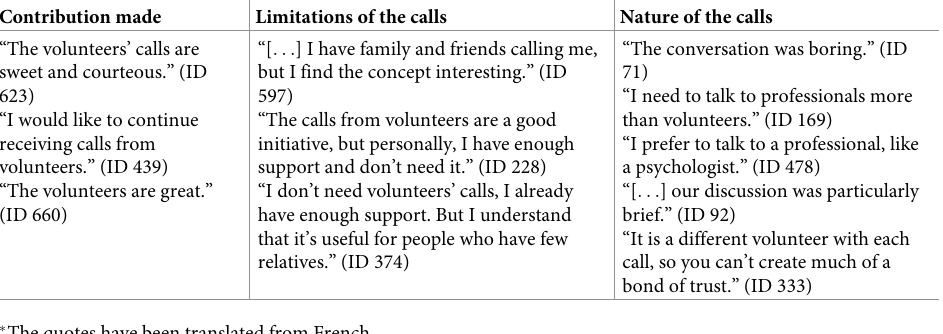
Table 1. Comments made by patients on the courtesy phone calls �